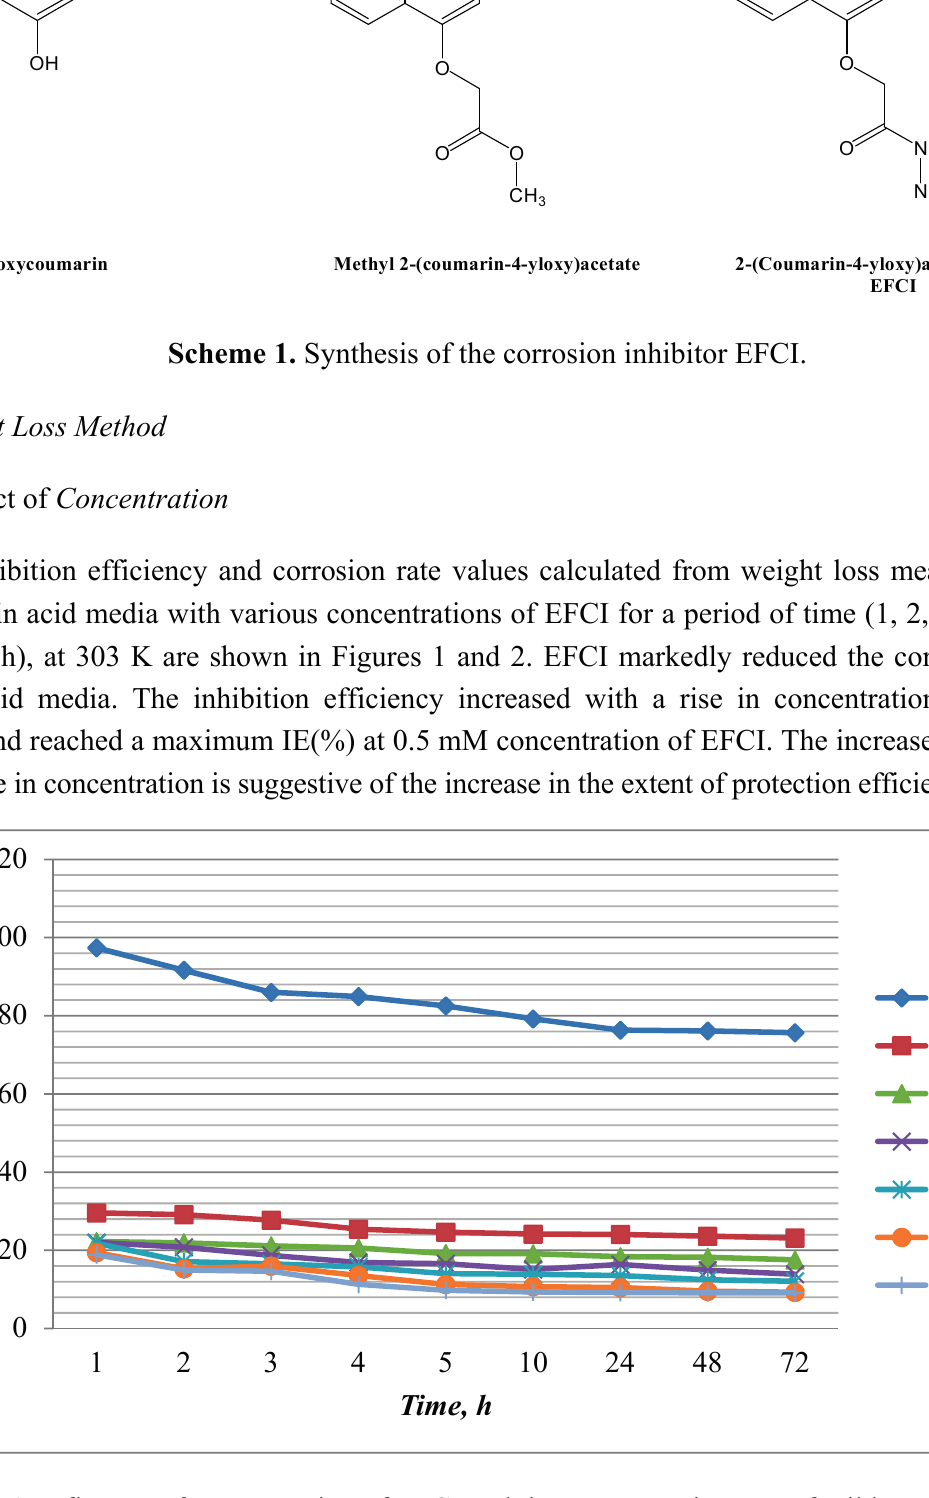
Figure 1. Influence of concentration of EFCI and time on corrosion rate of mild steel at 303